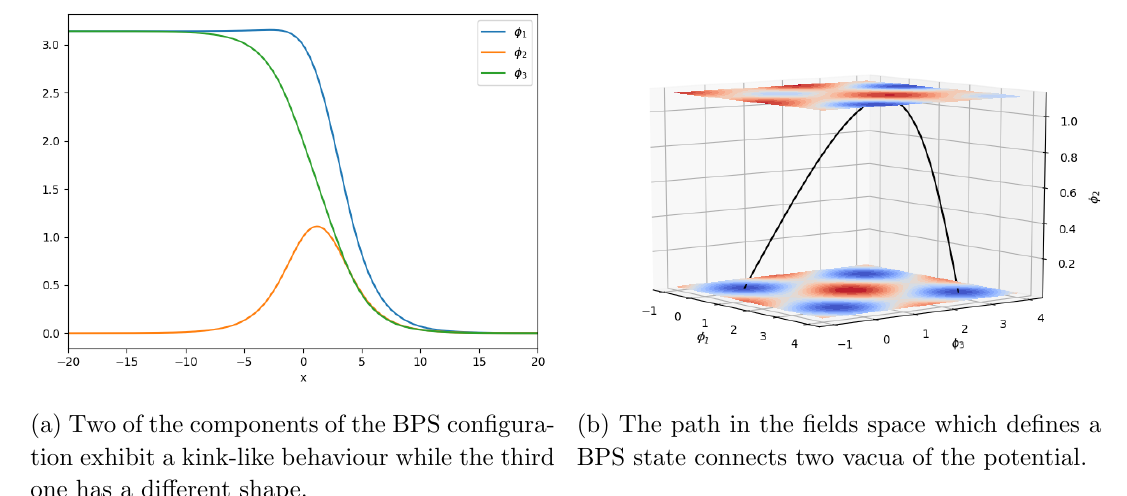
Figure 12. A BPS solution of the su (4) FKZ